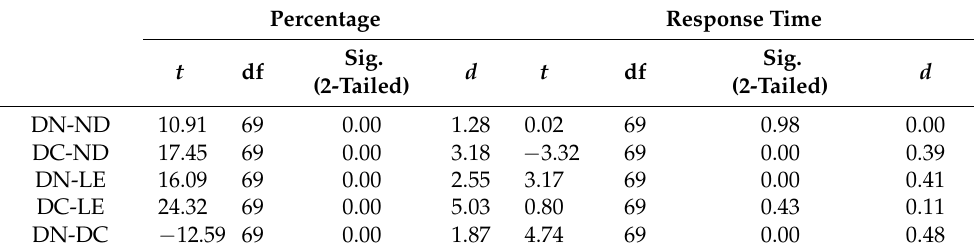
Table 4. Paired t -tests on the overall scores of percentage and response times (CI = 95%). Percentage Response Time Sig. Sig. d d t df t df (2-Tailed) (2-Tailed) DN-ND 10.91 69 0.00 1.28 0.02 69 0.98 0.00 DC-ND 17.45 69 0.00 3.18 − 3.32 69 0.00 0.39 DN-LE 16.09 69 0.00 2.55 3.17 69 0.00 0.41 DC-LE 24.32 69 0.00 5.03 0.80 69 0.43 0.11 DN-DC − 12.59 69 0.00 1.87 4.74 0.00